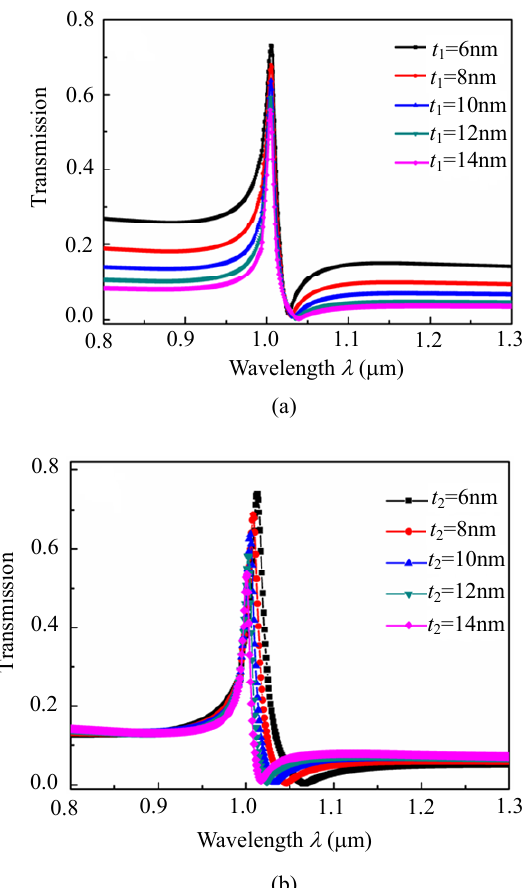
Fig. 5 Transmission spectra of the MIM waveguide coupled with two rings and rectangular cavities with varying coupling distances (a) t 1 ( t 2 = 10 nm) and (b) t 2 ( t 1 = 10 nm). Here, r = r ′ = 115 nm, n = 1, d = 50 nm, and h = 100 nm.